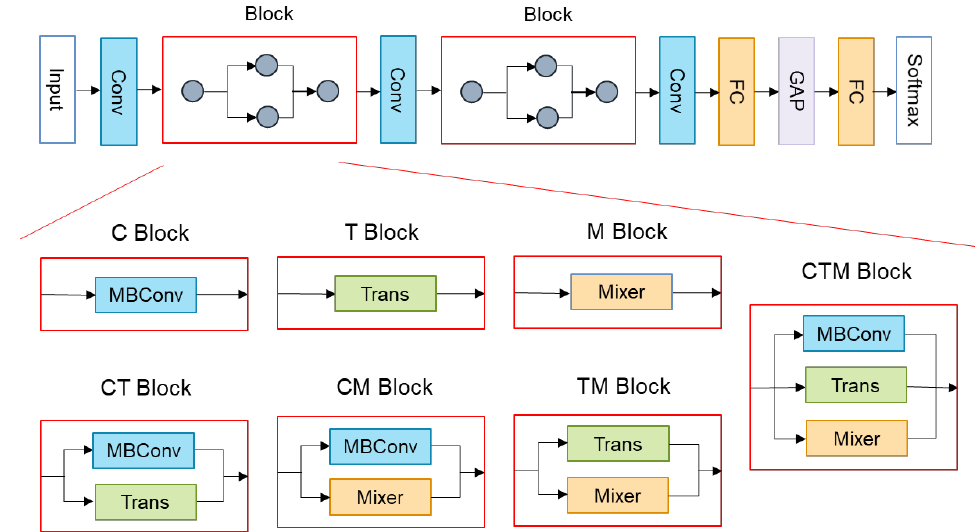
Figure 4. Hybrid Figure 4. Hybrid architecture. Table 1. 7 hybrid models of different combinations in this study. Model